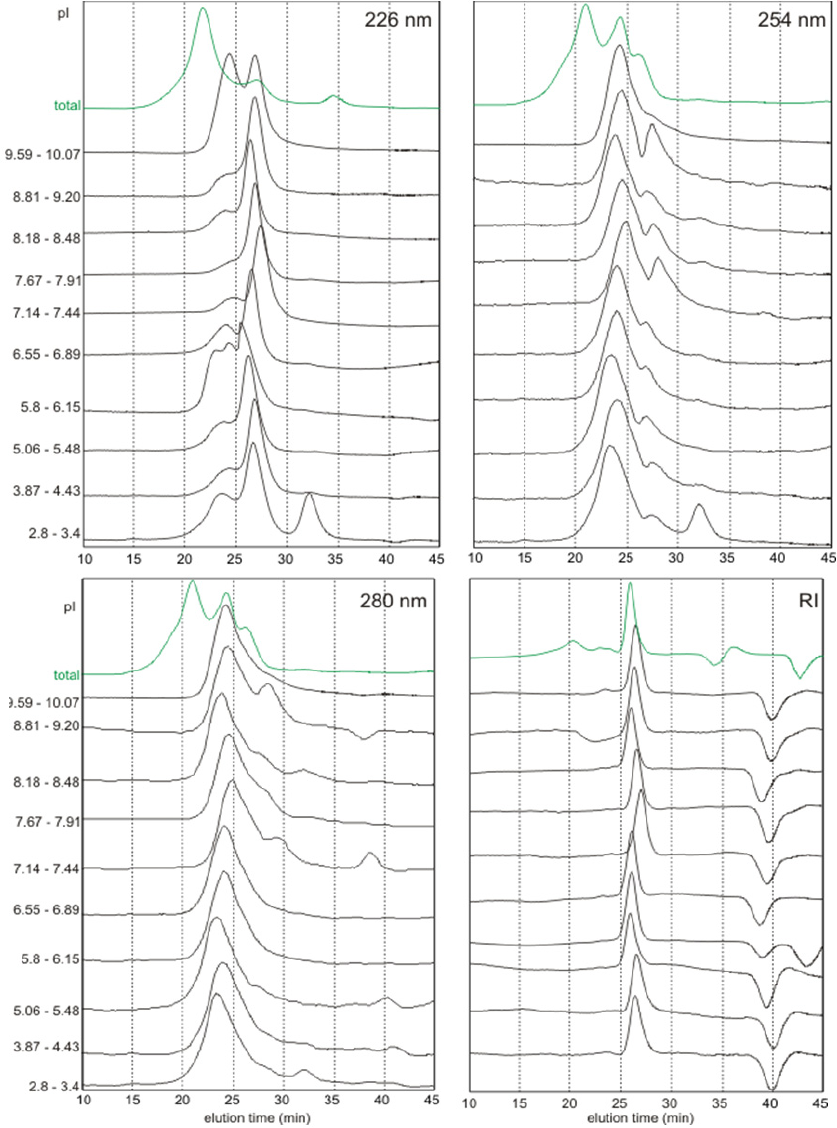
Figure 5. HPLC profiles showing the molecular weights of every pI fraction and of the non-fractionated SOM (total), displayed according to the UV wavelength detection and refractometric index. The diversity of the molecular weights in different fractions is